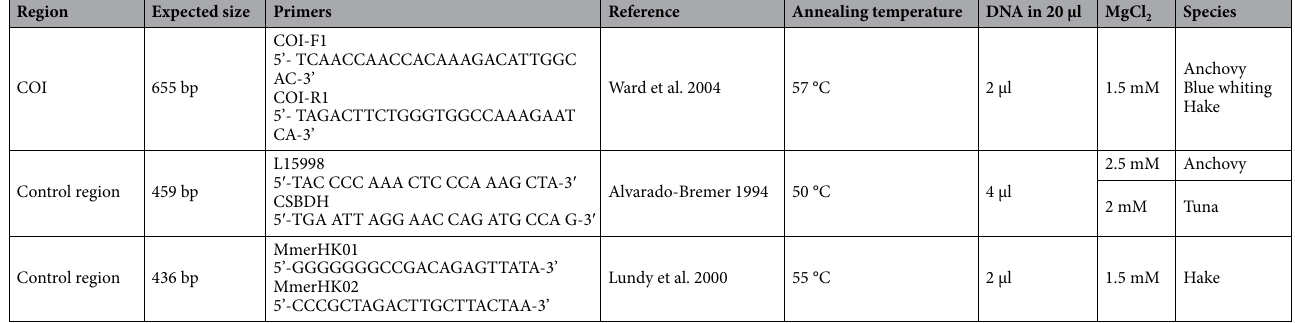
Table 4. Molecular tools employed in the analysis of fish fraud in this study, per